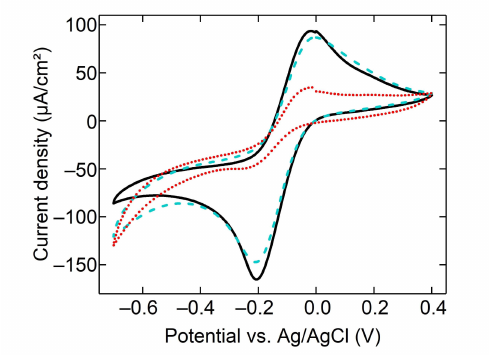
Figure 9. CVs of unmodified (solid line, black), and covalently (dotted line, red) and noncovalently (dashed line, cyan) modified graphene electrodes for 1 mM hexa-ammine-ruthenium (III) in 0.1 M KCl at scan rate of 100 mV /